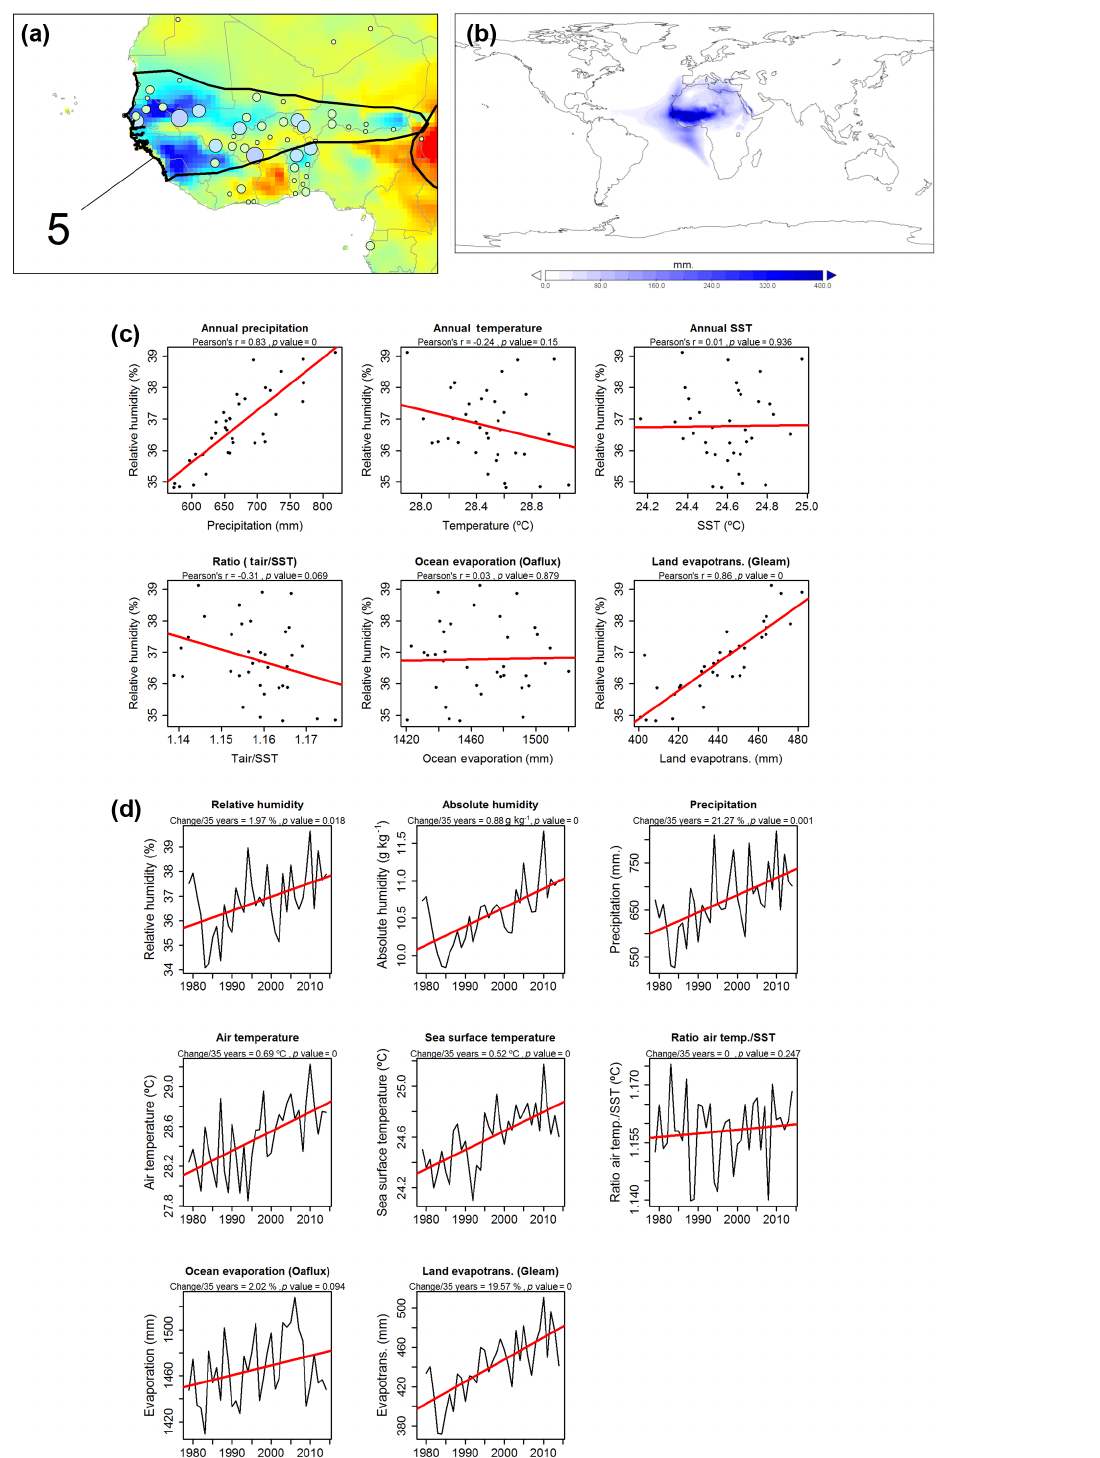
Figure 5. (a) Annual RH humidity trends in the western Sahel (region 6); (b) average ( E – P )>0 at the annual scale to identify the main humidity sources in the region (mmyr − 1 ). (c) Relationships between the de-trended annual RH and the de-trended annual variables for 1979–2014. (d) Annual evolution of the different variables corresponding to the western Sahel region. The magnitude of change and their corresponding statistical significance are indicated for each